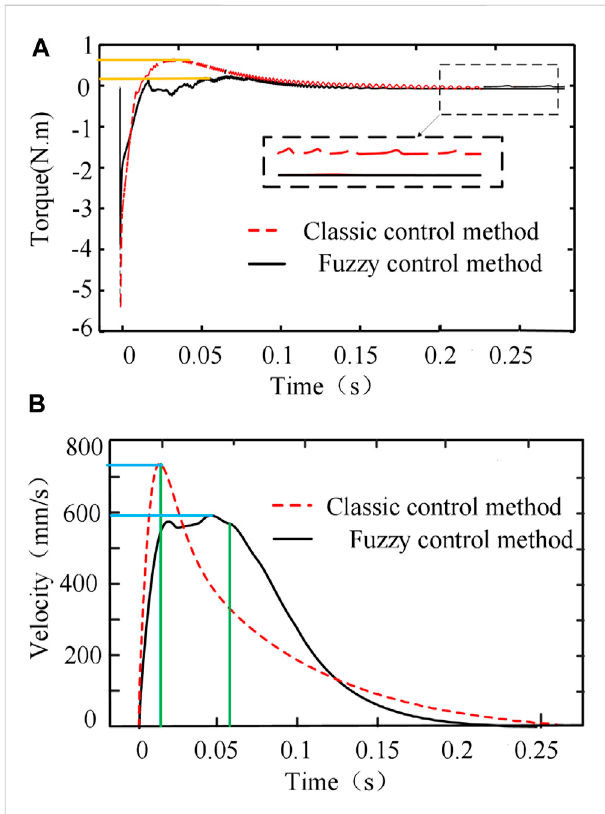
FIGURE 10 The response curve of X motor to 50 mm target displacement is obtainedfromco-simulation: (A) themotortorquecomparedwiththe classical PI algorithm and the fuzzy control algorithm and (B) the corresponding velocity comparison.